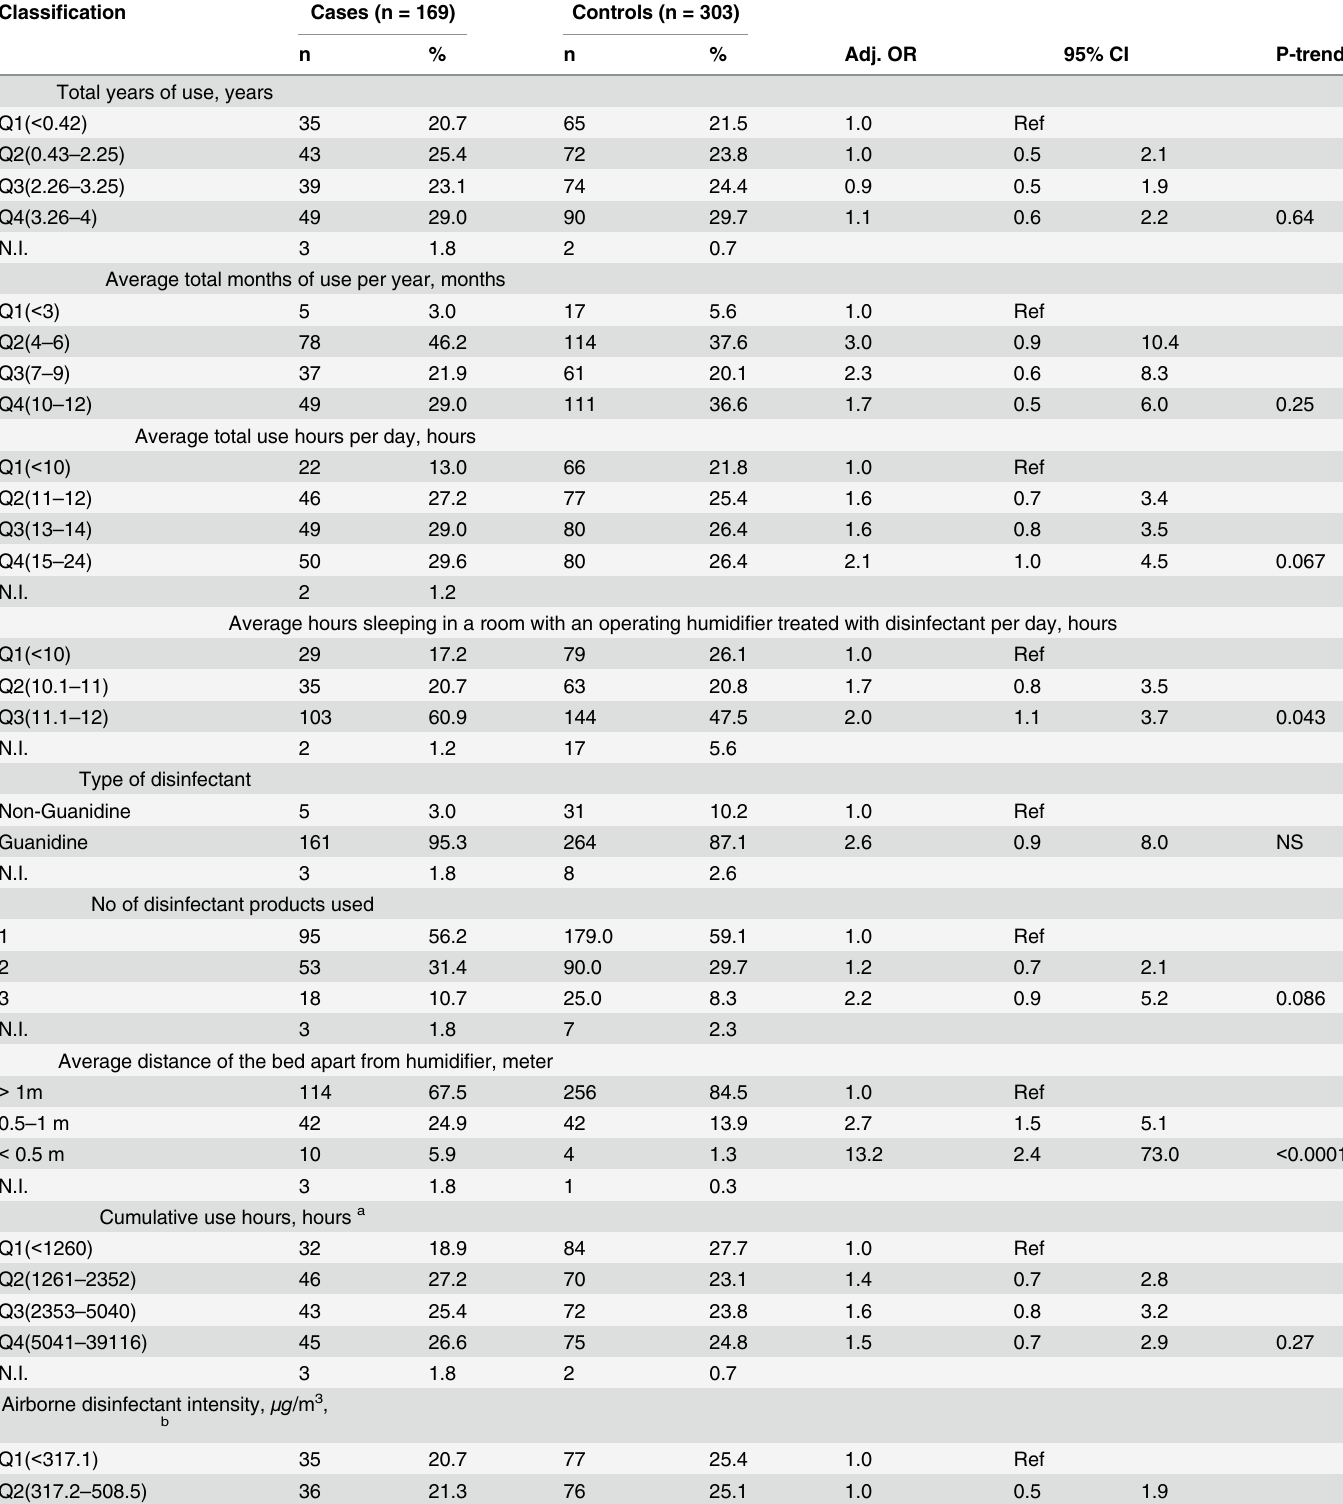
Table 3. Association between humidifier disinfectant exposure-related characteristics and HDLI risk. Classi fi